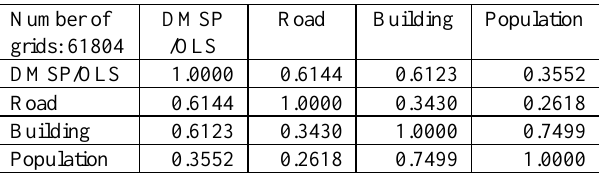
Table 6. Correlation table in rural area of Tohoku region Table 7 shows results of multiple regression analysis